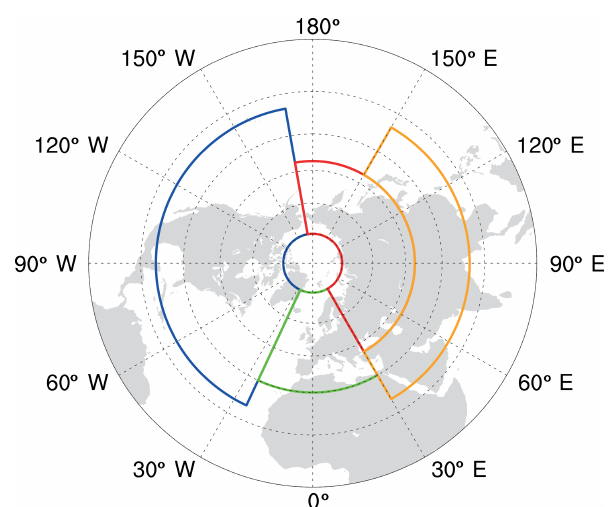
Figure 1. Regions indicate the area used for averaging presented in Table 3. North America is in blue, Europe is in green, Russia is in red and central Asia is in